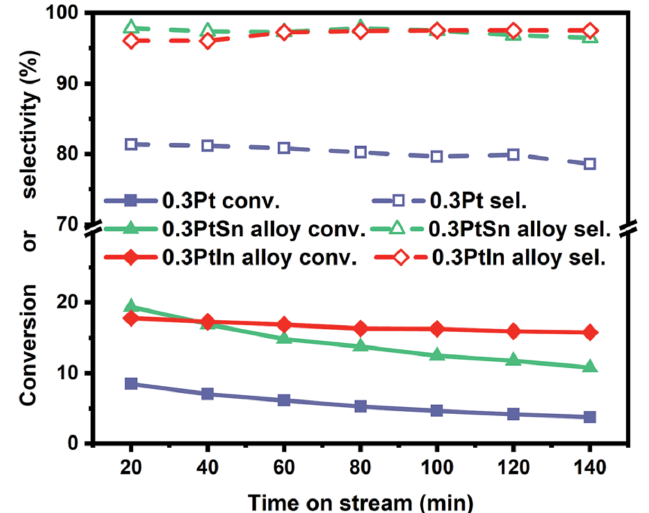
Figure 6. Conversion and selectivity of Pt 3 In, Pt and Pt 3 Sn catalysts in PDH process. Reaction conditions: T = 600 ◦ C, atmospheric pressure, total flow rate = 50 mL/min. (Reprinted with permission from [33]. Published by The Royal Society of